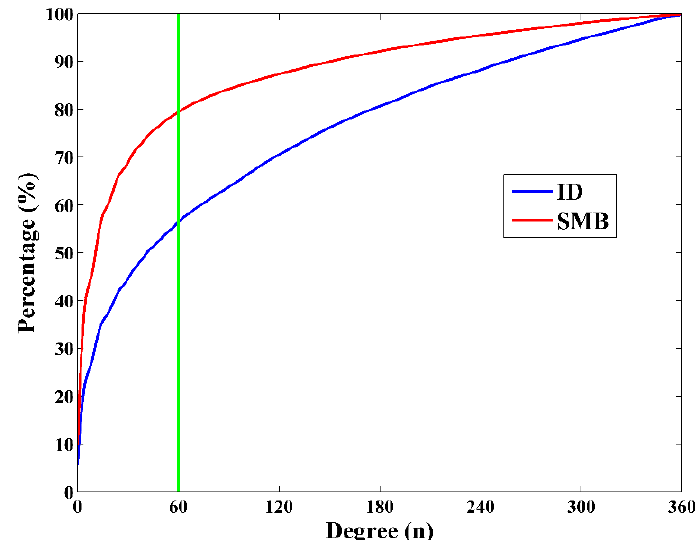
Figure 7. The percentage of accumulated degree amplitudes in total for the ice discharge (ID; blue) and the SMB (red). The ID grid point values are simulated from the Antarctic ice velocity [32], and the SMB grid point values are shown in Figure 4a, all grid values are expanded into spherical harmonic coefficients of degree and order 360. The accumulated degree amplitudes [94] of n are estimated over a spectral band from 0 to n , and the total amplitudes are estimated over the spectral band from 0 to 360. The green line is the location of n = 60.